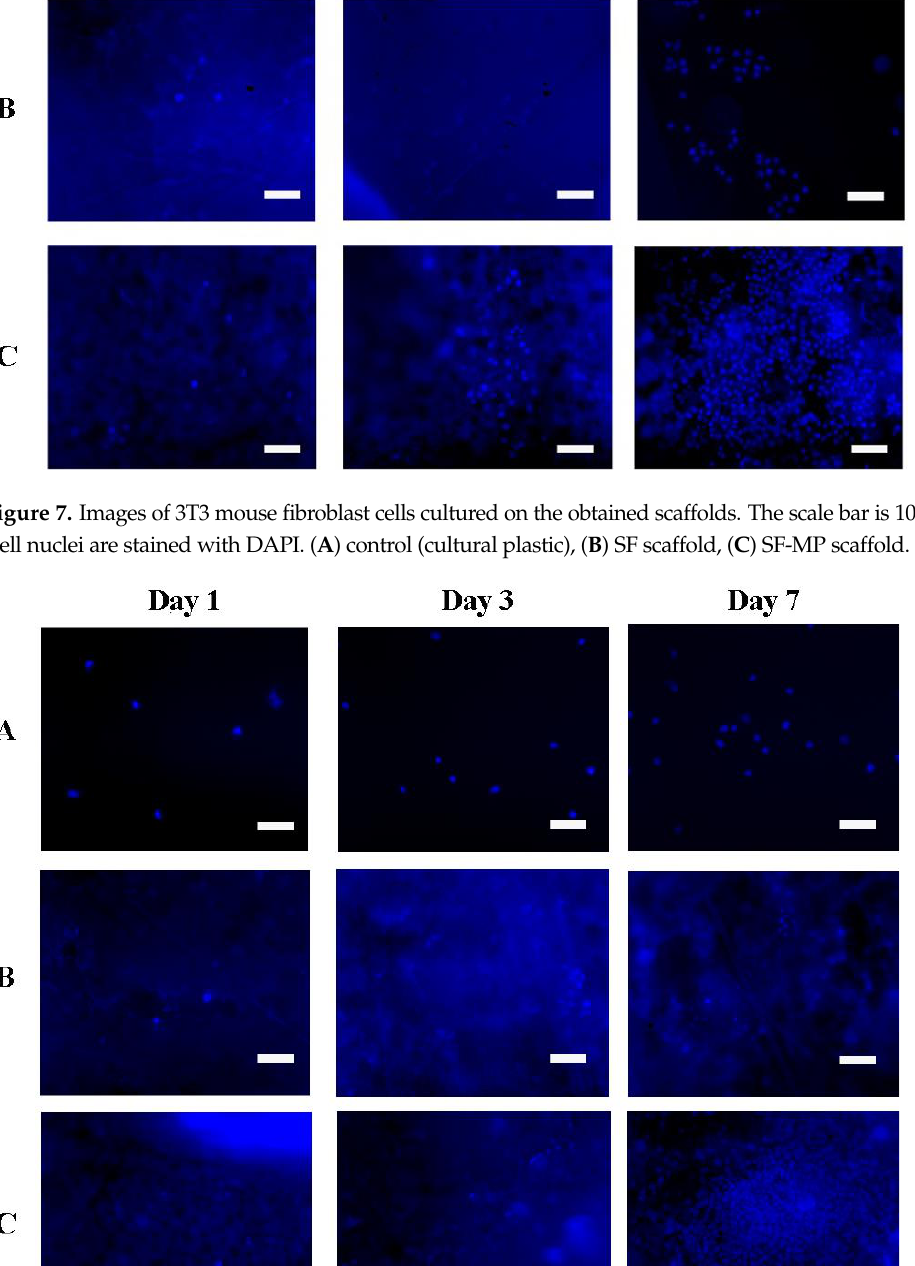
Figure 8. Images of Hep-G2 cells cultured on the obtained scaffolds. The scale bar is 100 µm. Cell nuclei are stained with DAPI. ( A ) control (cultural plastic), ( B ) SF scaffold, ( C ) SF-MP scaffold. Quantitative results of proliferative activity analysis of 3T3 and Hep-G2 culture cells are depicted in Figures 9 and 10 correspondingly. It was shown that all scaffolds based on silk fibroin supported cell adhesion; there were no significant differences between dif- ferent groups of samples and control. Furthermore, during the experiment to assess pro- liferation, the largest number of cells on the 7th day of the experiment of both cultures was observed on scaffolds in the form of a film based on silk fibroin, with microparticles of decellularized rat liver tissue included in the composition. On composite scaffolds, the proliferative activity of cells on the 7th day of observation was higher than on unmodi- fied scaffolds.